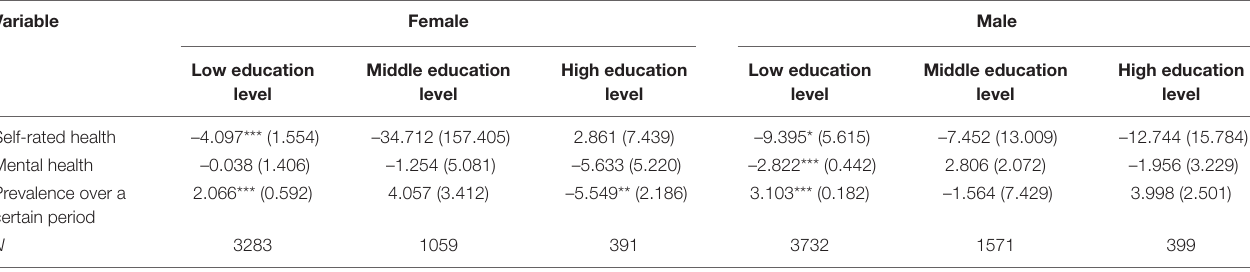
TABLE 5 | Endogenous problems (adjustment of minimum wage standards in various cities).